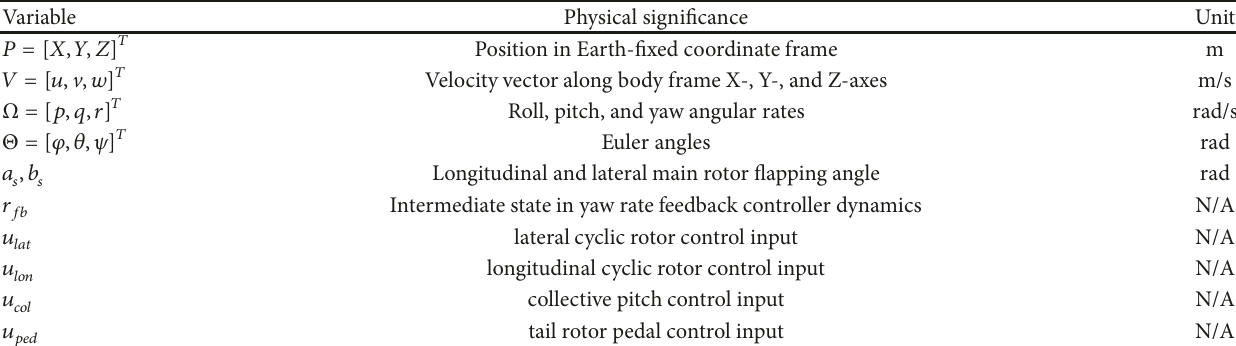
Table 1: Physical descriptions of the state and input variables of the helicopter dynamical